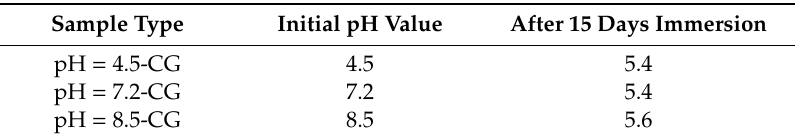
Table 3. pH values of